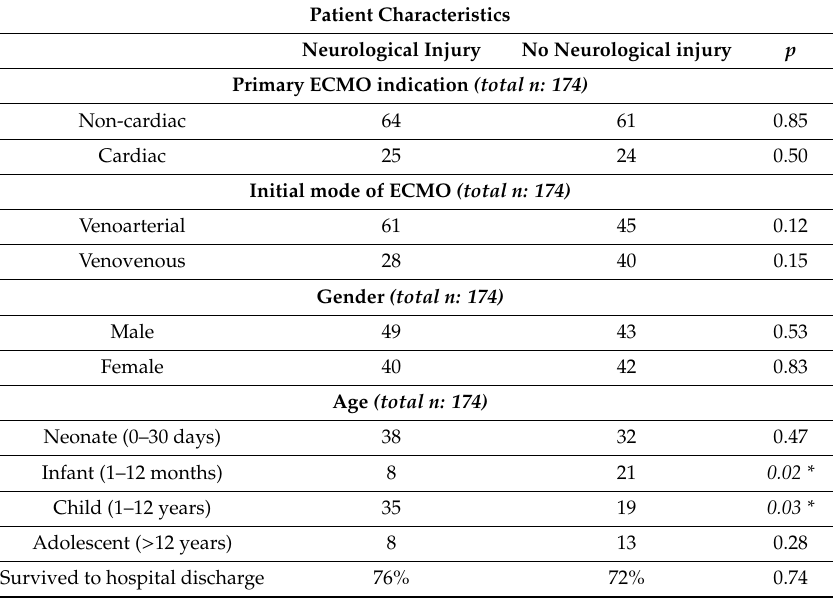
Table 2. Characteristics of patients in the injury vs no injury